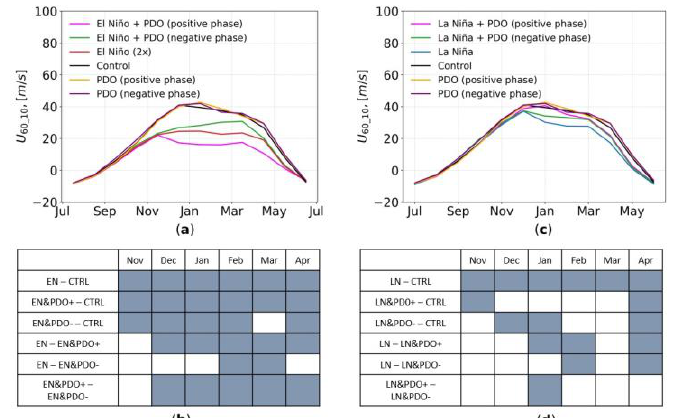
Figure 4. Monthly mean values of the SPV intensity, [m/s], averaged over 100 years according to the numerical experiments data: ( a ) CTRL (in black), EN (in red), PDO+ (yellow), PDO − (violet), EN&PDO+ (pink), and EN&PDO− (green); ( c ) CTRL (in black), LN (blue), PDO+ (yellow), PDO − (violet), LN&PDO+ (pink), and LN&PDO − (green). ( b , d ) are tables of statistically significant differences between the intensity of the SPV obtained in different experiments, the months with statistically significant differences at 5% level are marked in dark